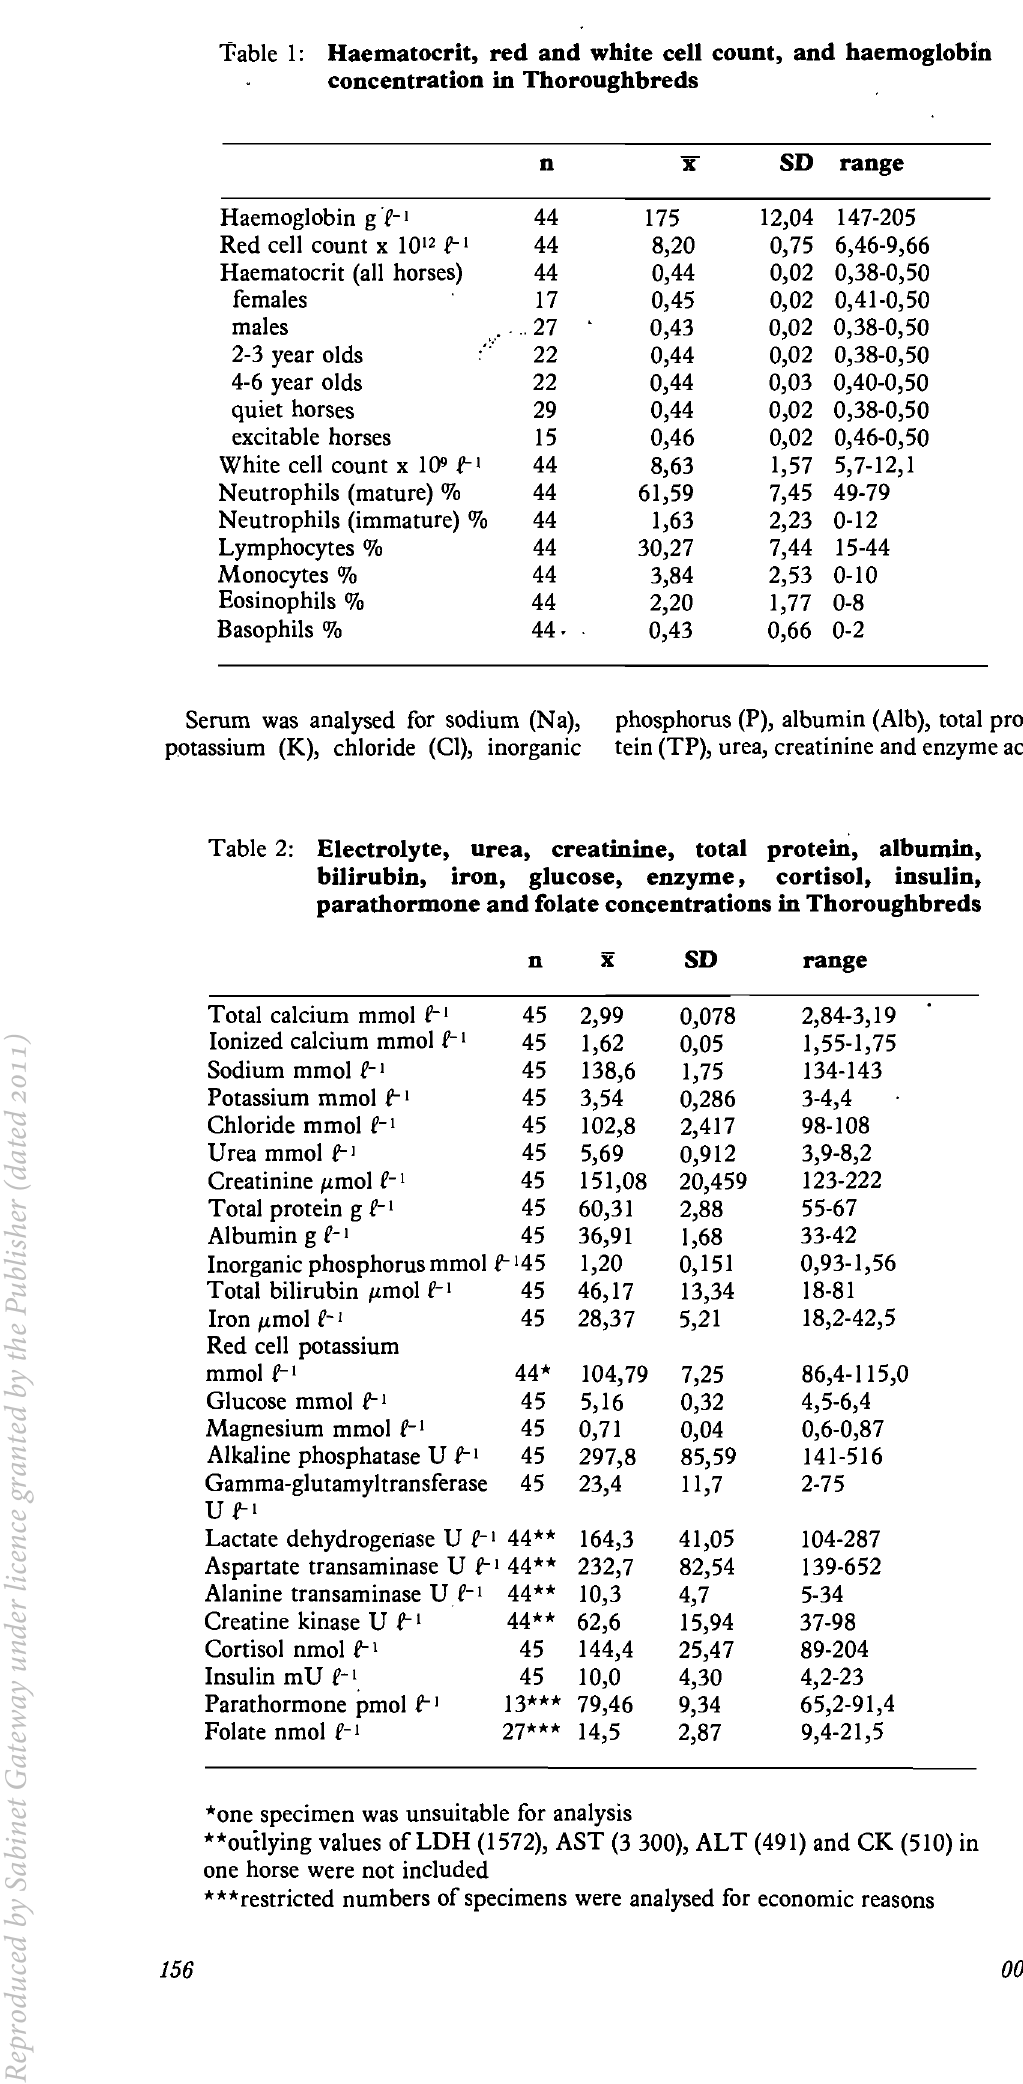
'table I: Haematocrit, red and white cell count, and haemoglobin concentration in Thoroughbreds